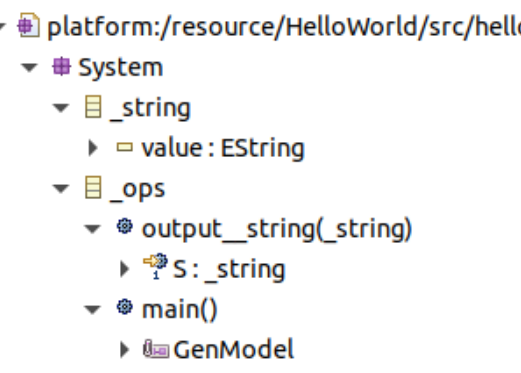
Figure 3. Ecore model compiled from the REX text in the “Hello, World! 2” example. Listing 11. Java code generated by EMF from the Ecore model compiled from the REX text in